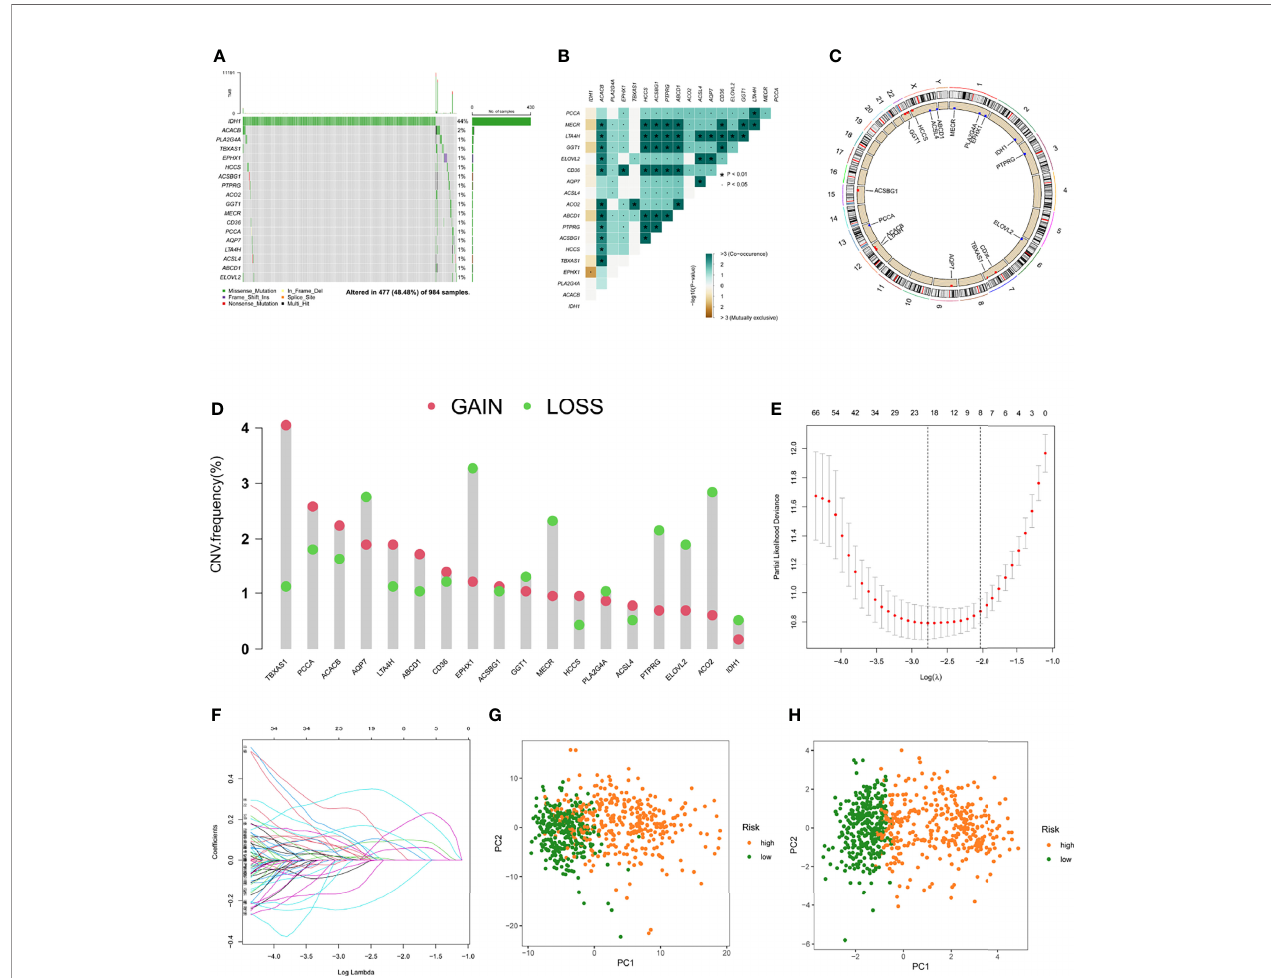
FIGURE 2 | Predictive risk score model development. (A) The frequency of mutations in 18 FAMDs in 984 glioma patients from the TCGA cohort. (B) Mutation co- occurrence and selection analysis for 18 genes involved in fatty acid metabolism. Green denotes co-occurrence; purple denotes exclusion. (C) Locations of CNV alterations in FAMDs on 23 chromosomes. (D) Frequencies of CNV gain, loss, and non-CNV among FAMDs. (E) LASSO coef fi cients for the FAMDs involved in fatty acid metabolism. (F) Gene discovery for the construction of a predictive risk score model. (G) Principal component analysis of FAMDs in glioma. (H) In the TCGA cohort, principal component analysis was used to identify cancers from standard samples using a fatty acid metabolism vulnerability index. High-risk patients were represented by the red group, whereas the blue group represented low-risk patients. *P<0.01, (cid:129)